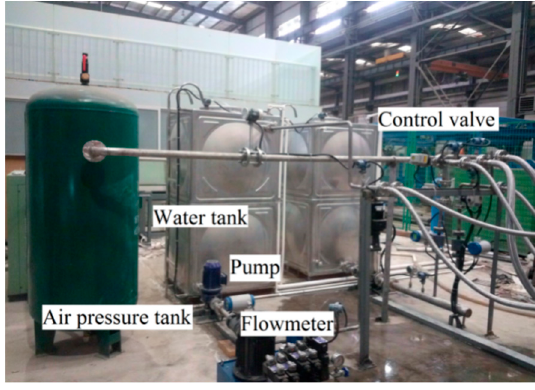
Figure 2. Air-water spray system.